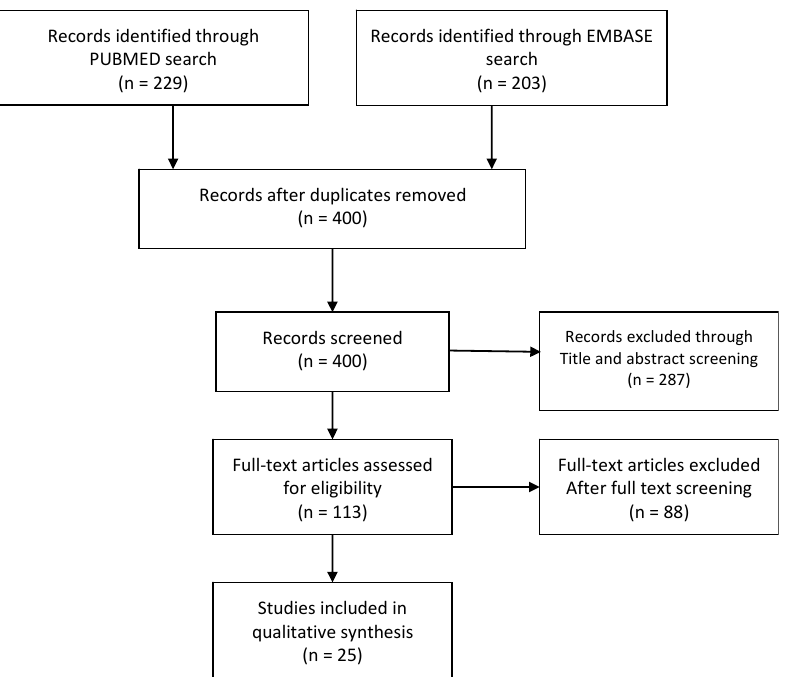
Figure 1. PRISMA flow diagram of the study selection process.